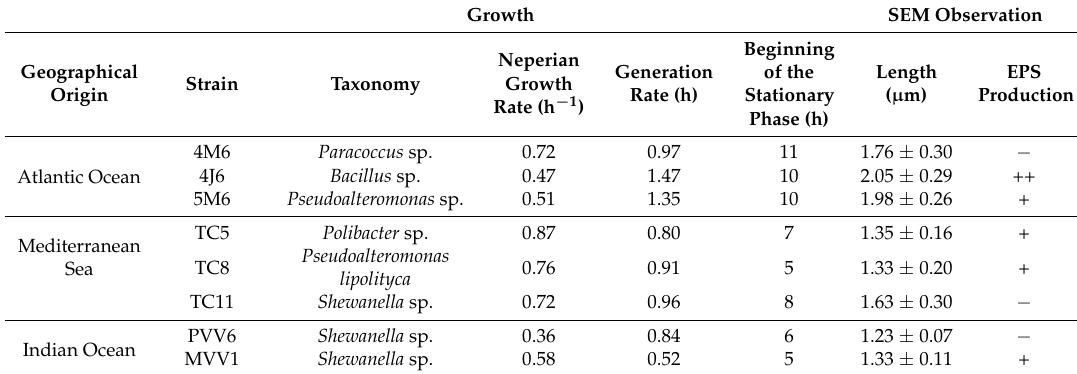
Table 1. Characterization of bacterial growth and morphology.